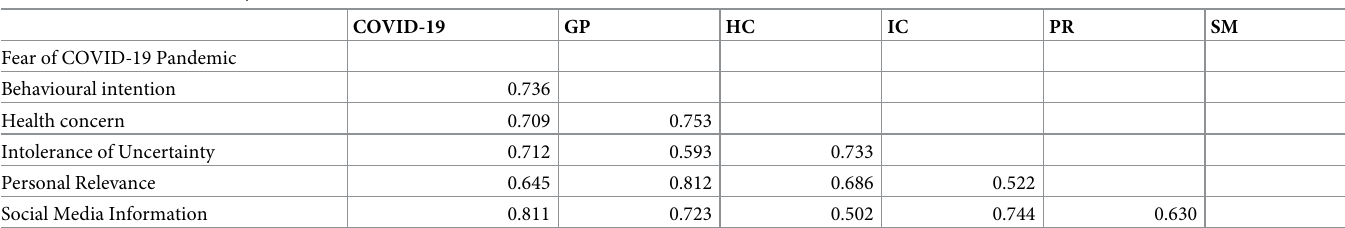
Table 3. Discriminant validity (Heterotrait-Monotrait Ratio) (HTMT).